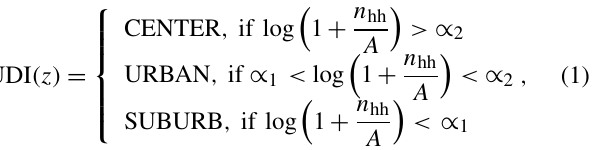
cording to the logarithm of population